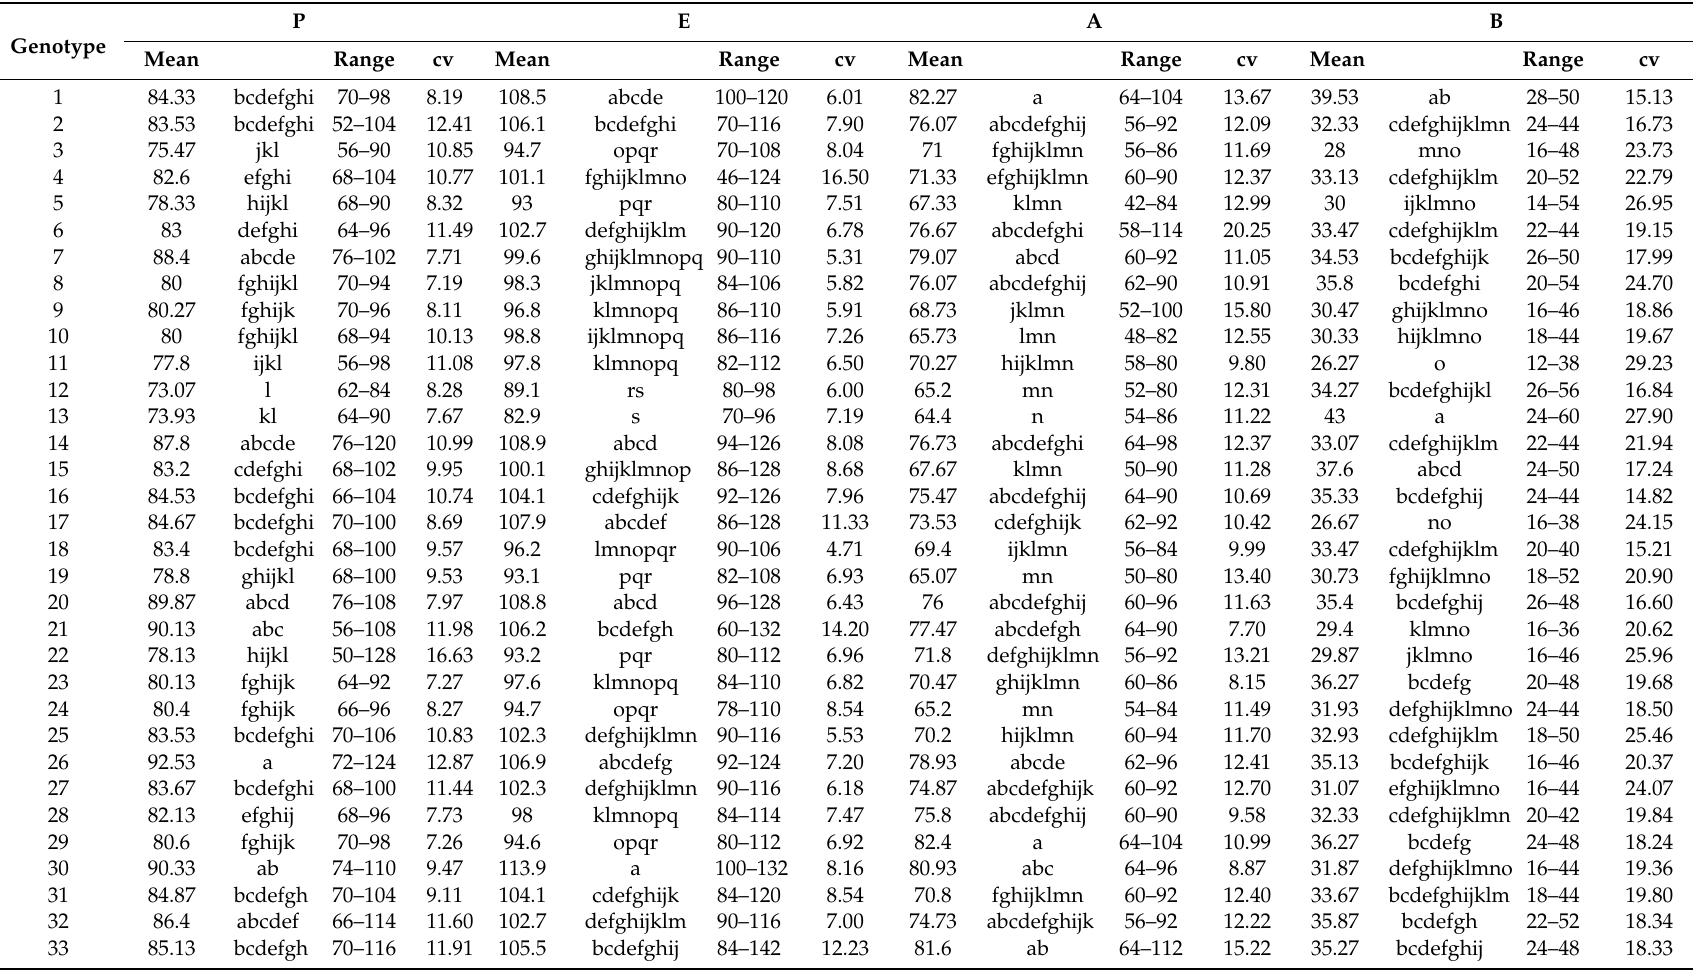
Table A2. Minimal, maximal, and mean values as well as coe ffi cient of variation (cv, in %) for P, E, A and B. In columns, means followed by the same letters are not significantly di ff